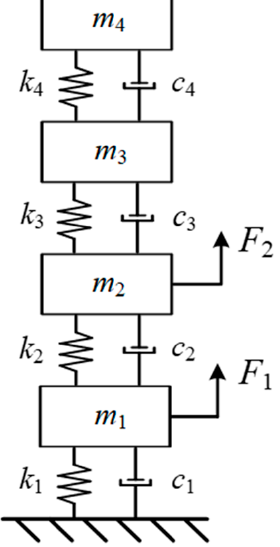
Figure 3. Four-degree-of-freedom spring-damping-mass system. Table 1. Two dynamic load components.